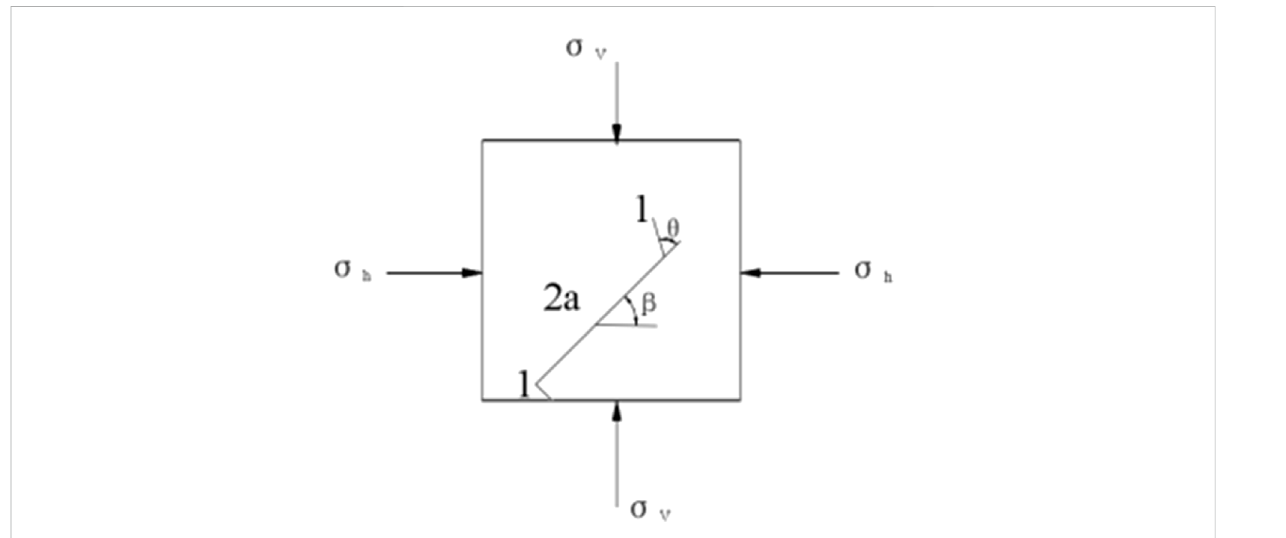
FIGURE 2 Schematic diagram of bidirectional stress on the fracture in the coal